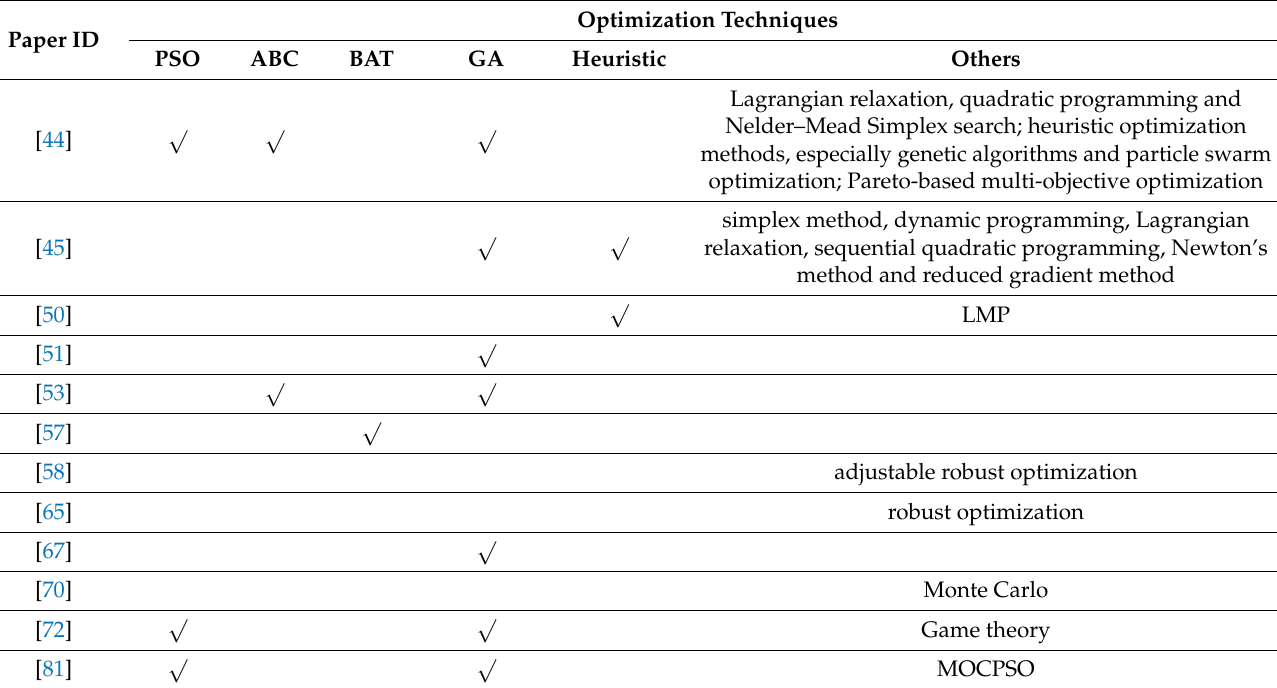
Table 3. Summary of reports for used optimization techniques in the